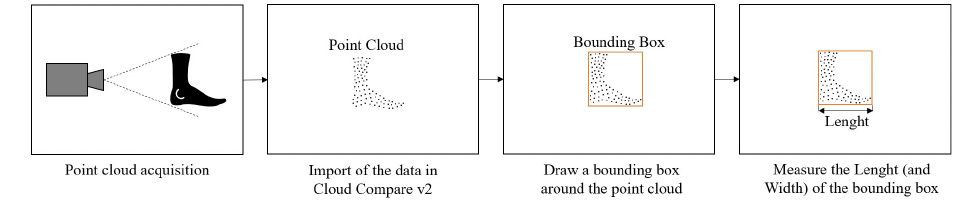
Figure 5. Experimental procedure for length and width measurement.